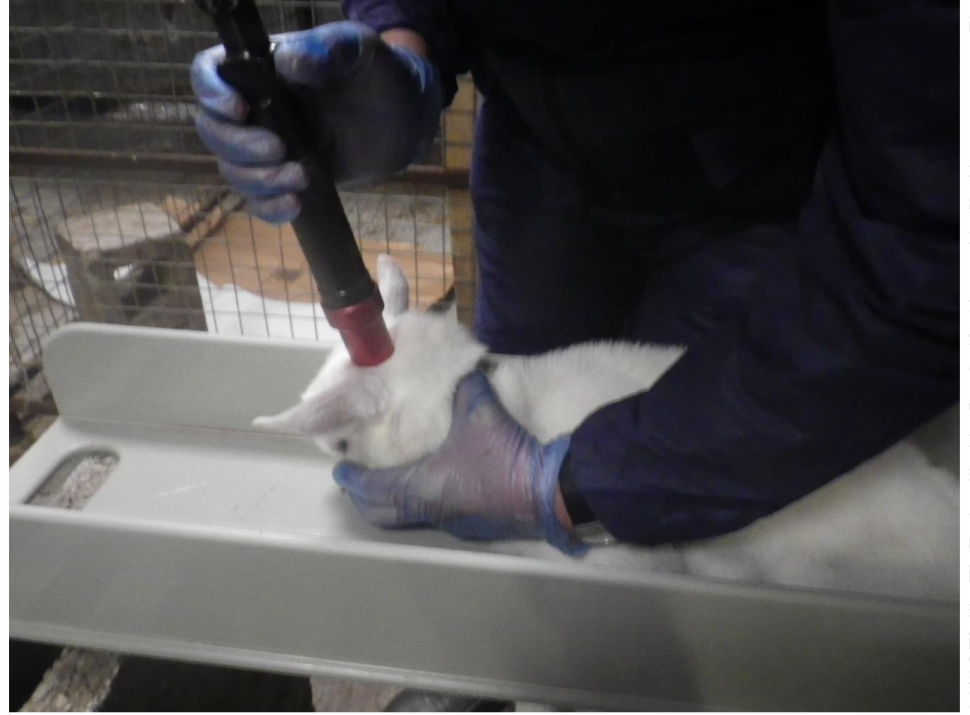
Figure 13. Revised shoot position for a neonate lamb. At the back of the head, on the midline, with the chin tucked into the neck, a similar position to that used for goats in Grist, et al. [3] and Sutherland, et al.